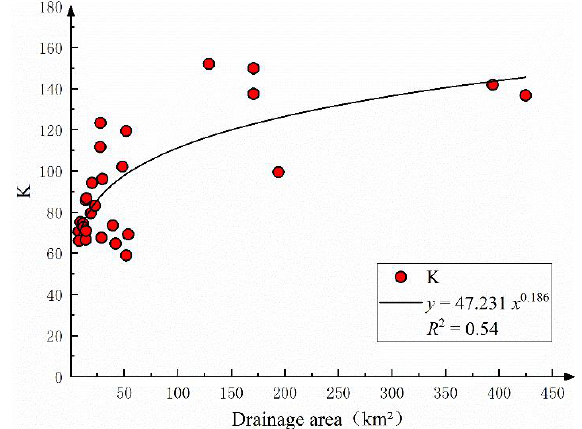
Figure 7. Relationship between K and drainage